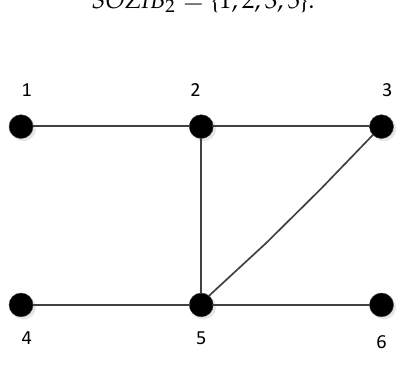
Figure 1. Six-node test system.